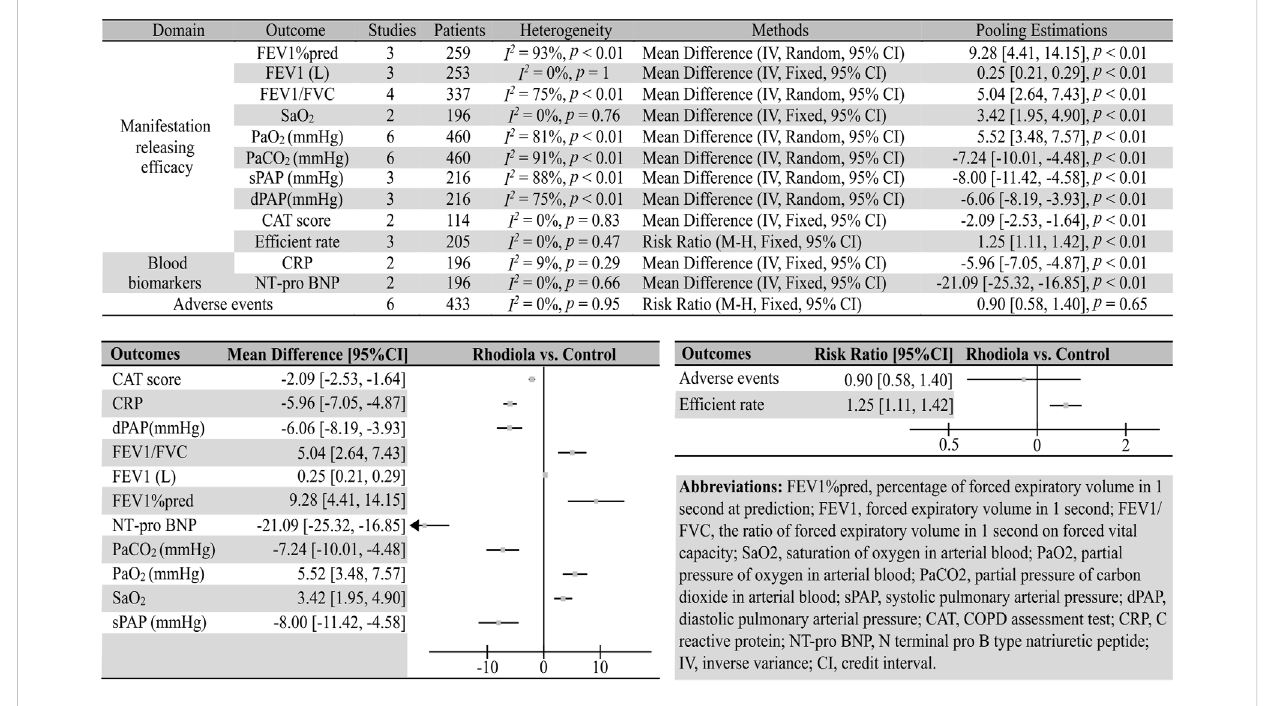
FIGURE 3 Summary of the meta-analysis results of Rhodiola vs. placebo in patients with